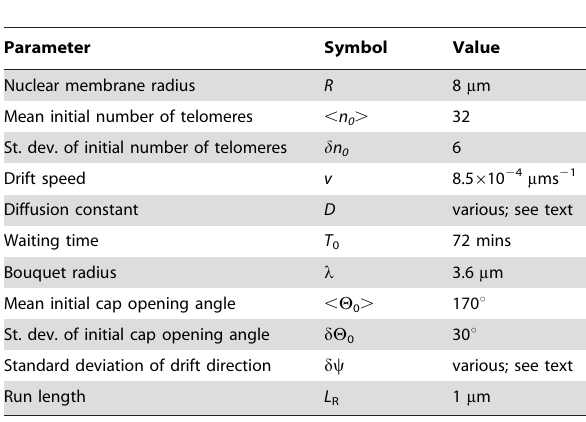
Table 1. Parameter values used in the